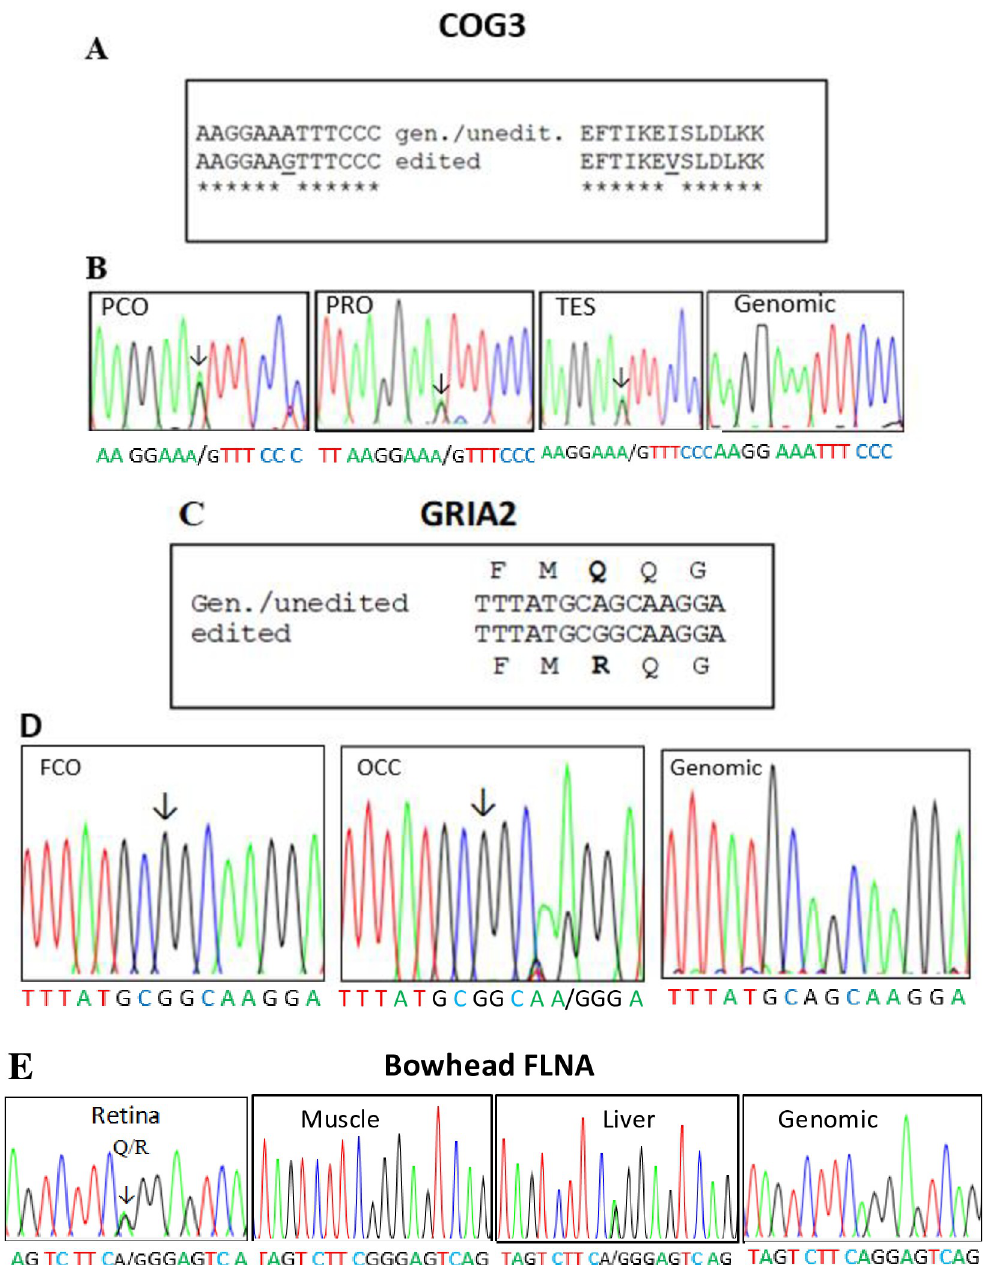
Fig 2. A) Porcine COG3 nucleotide alignment showing the genomic/unedited sequence (upper line) and the edited sequence below. B) Electropherograms showing editing in porcine parietal cortex (PCO), prostate (PRO) and testis (TES). The adenosine subject to editing is indicated by an arrow. Editing degrees are shown below. C) Porcine GRIA2 nucleotide alignment displaying the genomic/unedited sequence (upper line) and the edited sequence below. D) Electropherograms showing the porcine GRIA2 sequences with editing in frontal cortex (FCO) and occipital cortex (OCC). E) Electropherograms showing editing of bowhead FLNA pre-mRNA in retina and optical